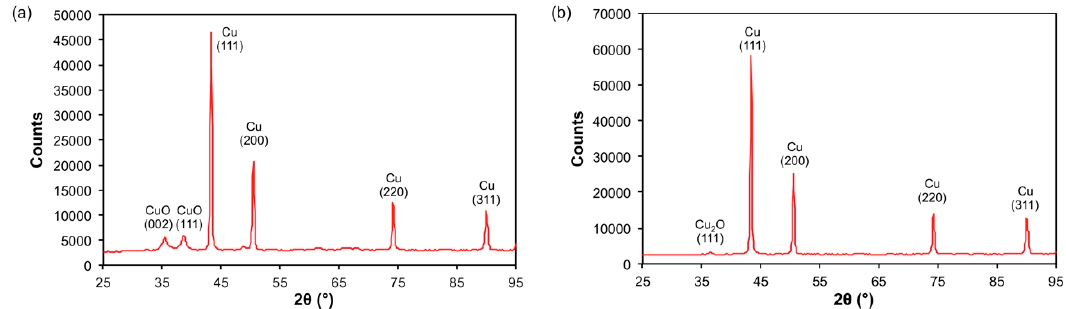
Figure 4. XRD of ( a ) electrodeposited copper and ( b ) Cu–SWCNT composite deposited with 4.0 wt% SWCNTs in CuSO 4 solution at a bath temperature of 60 °C, showing the presence of Cu (ICDD #04-009-2090), CuO (ICDD #04-007-1375), and Cu 2 O (ICDD #04-002-3214).